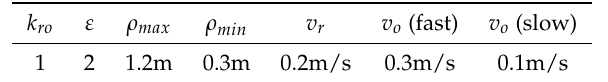
Table 2. The experimental parameters for moving obstacle